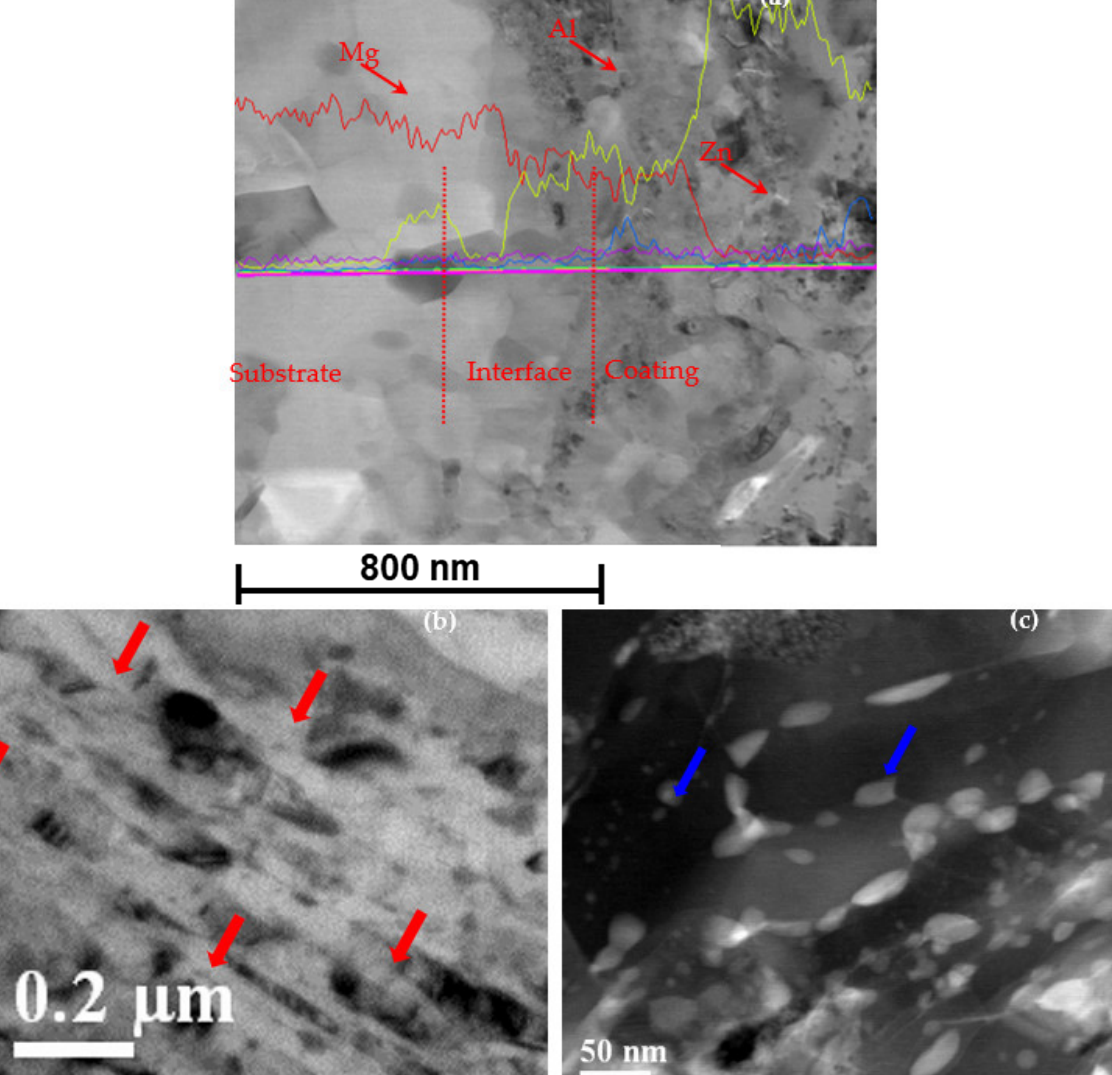
Figure 1. Typical bright field TEM images with EDX line scan show ( a ) the interface microstructure of AA7075 cold spray coating on AZ31B substrate, ( b ) bright field (BF), and ( c ) high-angle annular dark-field scanning transmission (HAADF-STEM) electron image taken at [110] zone axis coating show the elongated grains. Note: Red and blue arrows indicate the highly dense dislocation area and MgZn2 intermetallics, respectively.